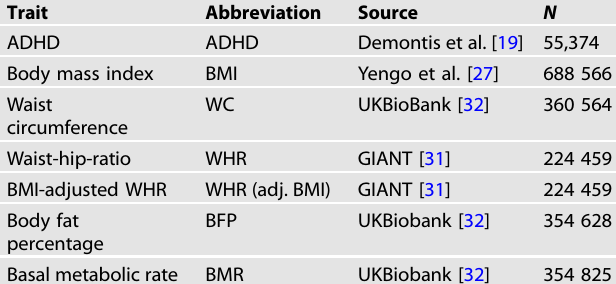
Table 1. Information on GWAS on ADHD and obesity-related